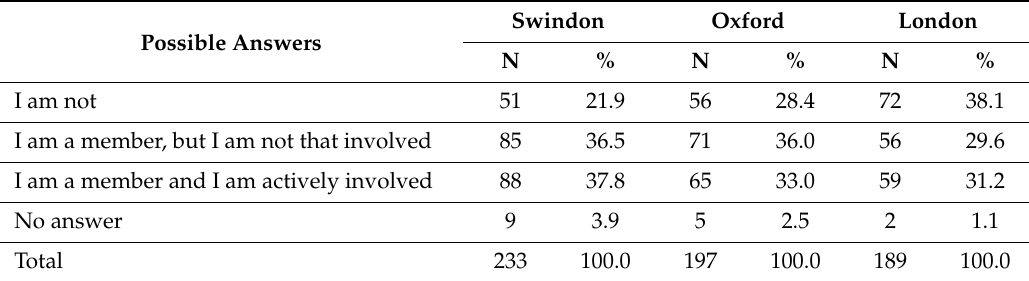
Table 2. Polish Catholic Mission in England and Wales is the largest Polish community organisation that brings together Poles in the UK. Are you a member of a Polish parish in England or Wales? Swindon Oxford London Possible Answers N % N % N % I am not 51 21.9 56 28.4 72